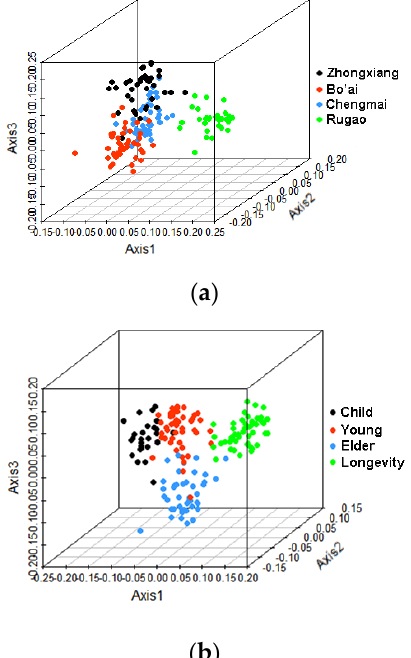
Figure 3. Canonical analysis of principal coordinates (CAP) based on high ‐ throughput sequencing data of the V4 region of the 16S rRNA gene. ( a ) CAP of gut microbiota of different region groups. ( b ) CAP of gut microbiota of different age groups.